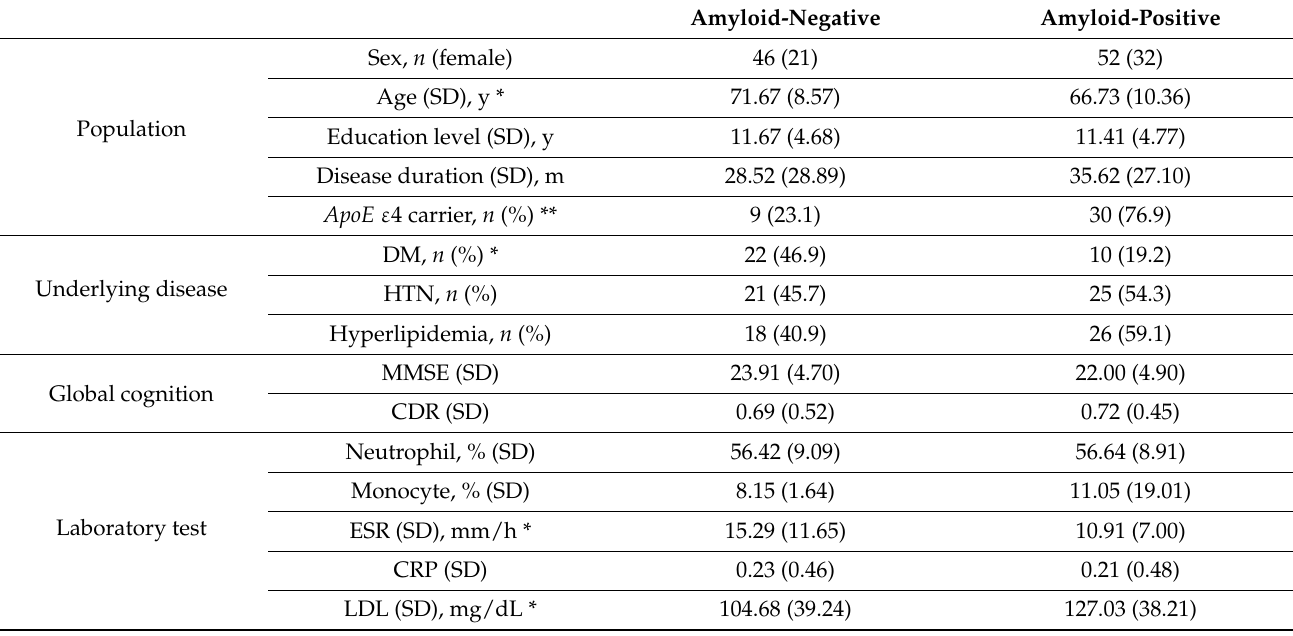
Table 4. Demographics and characteristics.